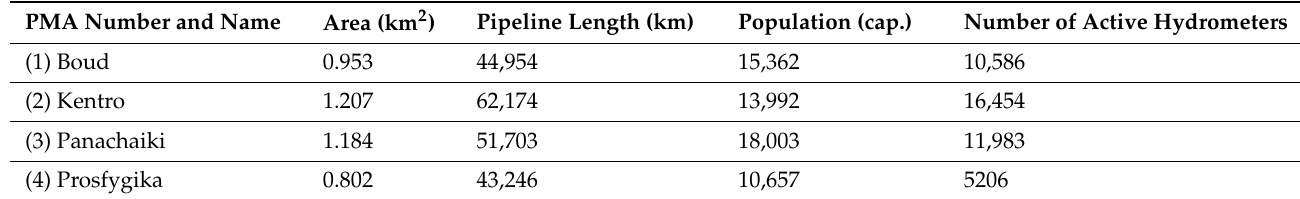
Table 1. Name, total area, length of the pipeline grid, population, and number of authorized active hydrometers of the four largest pressure management areas (PMAs) of the city of Patras. Numbers indicate the locations of PMAs in Figure 1.